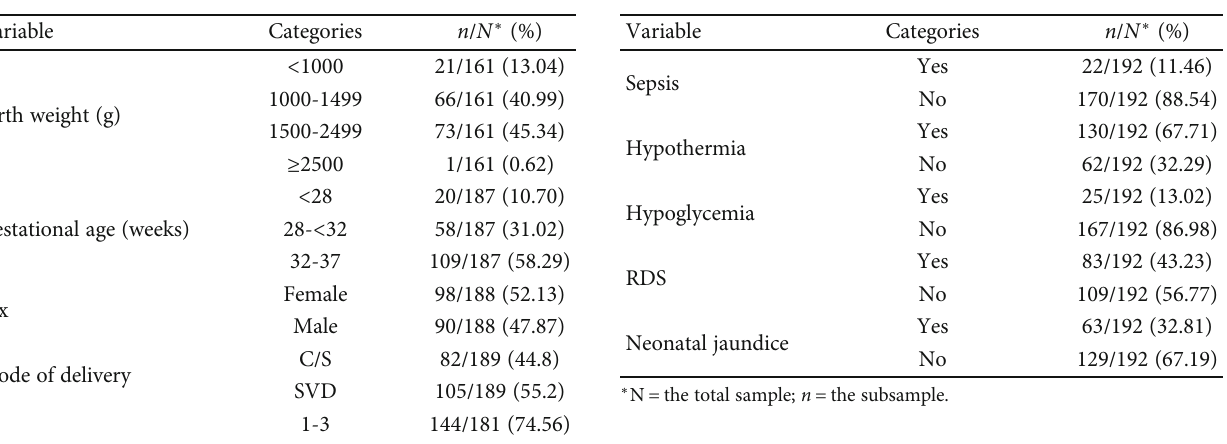
Table 1: Baseline characteristics of preterm babies at presentation to the NICU.